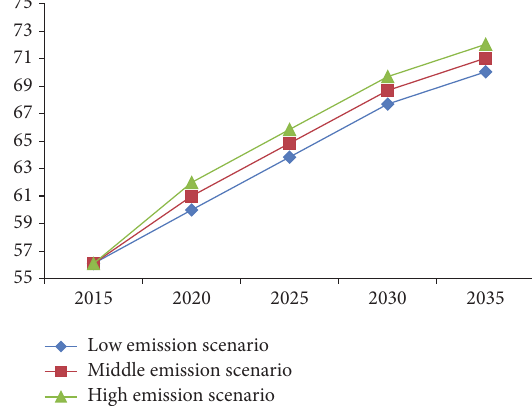
Figure 11: The trends of urbanization level in the low, middle, and high emission scenarios